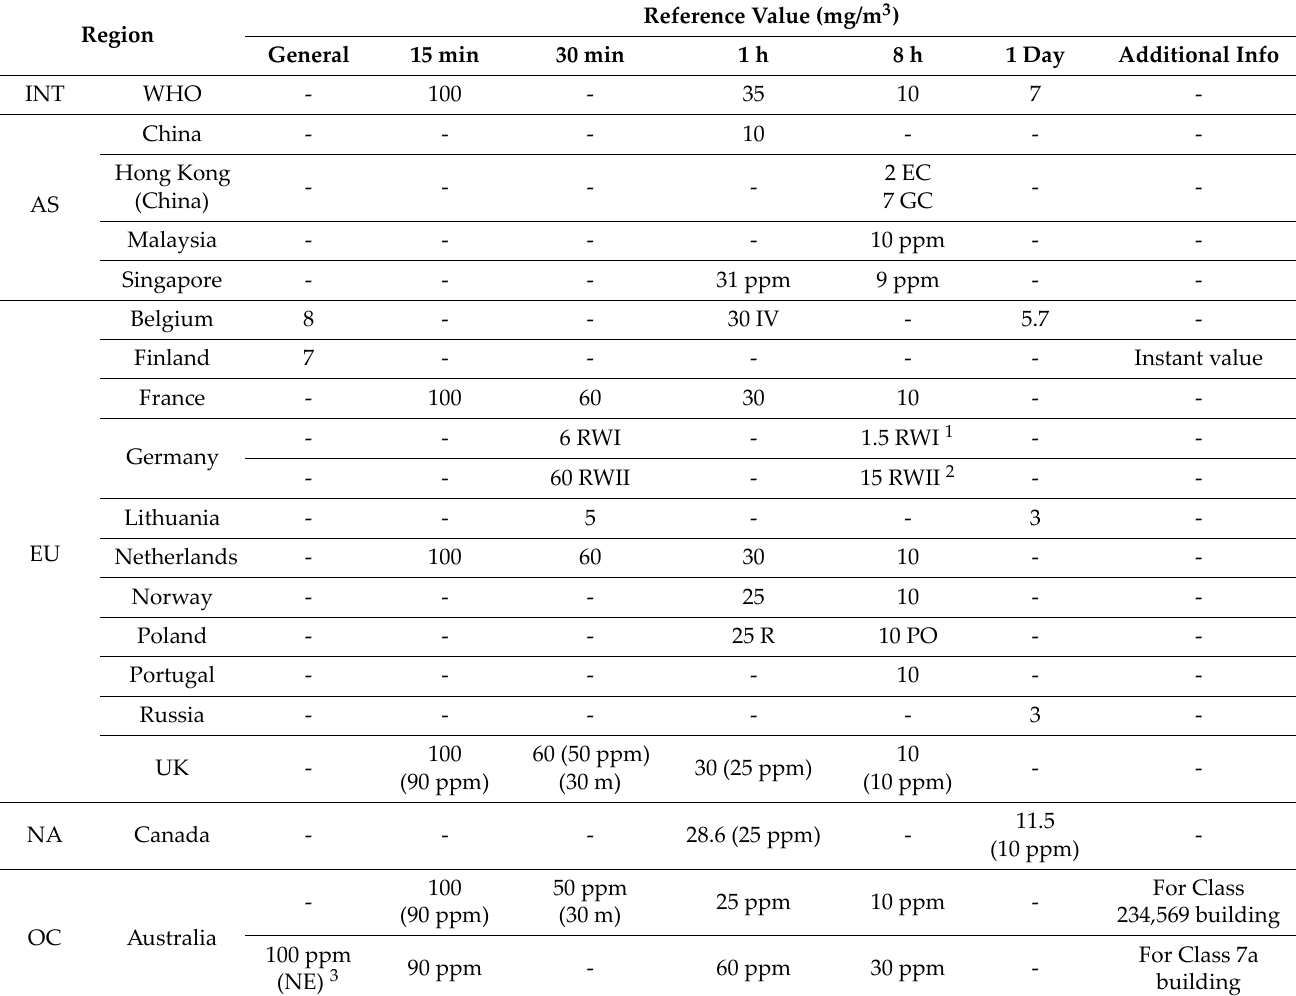
Table 7. Reference values for carbon